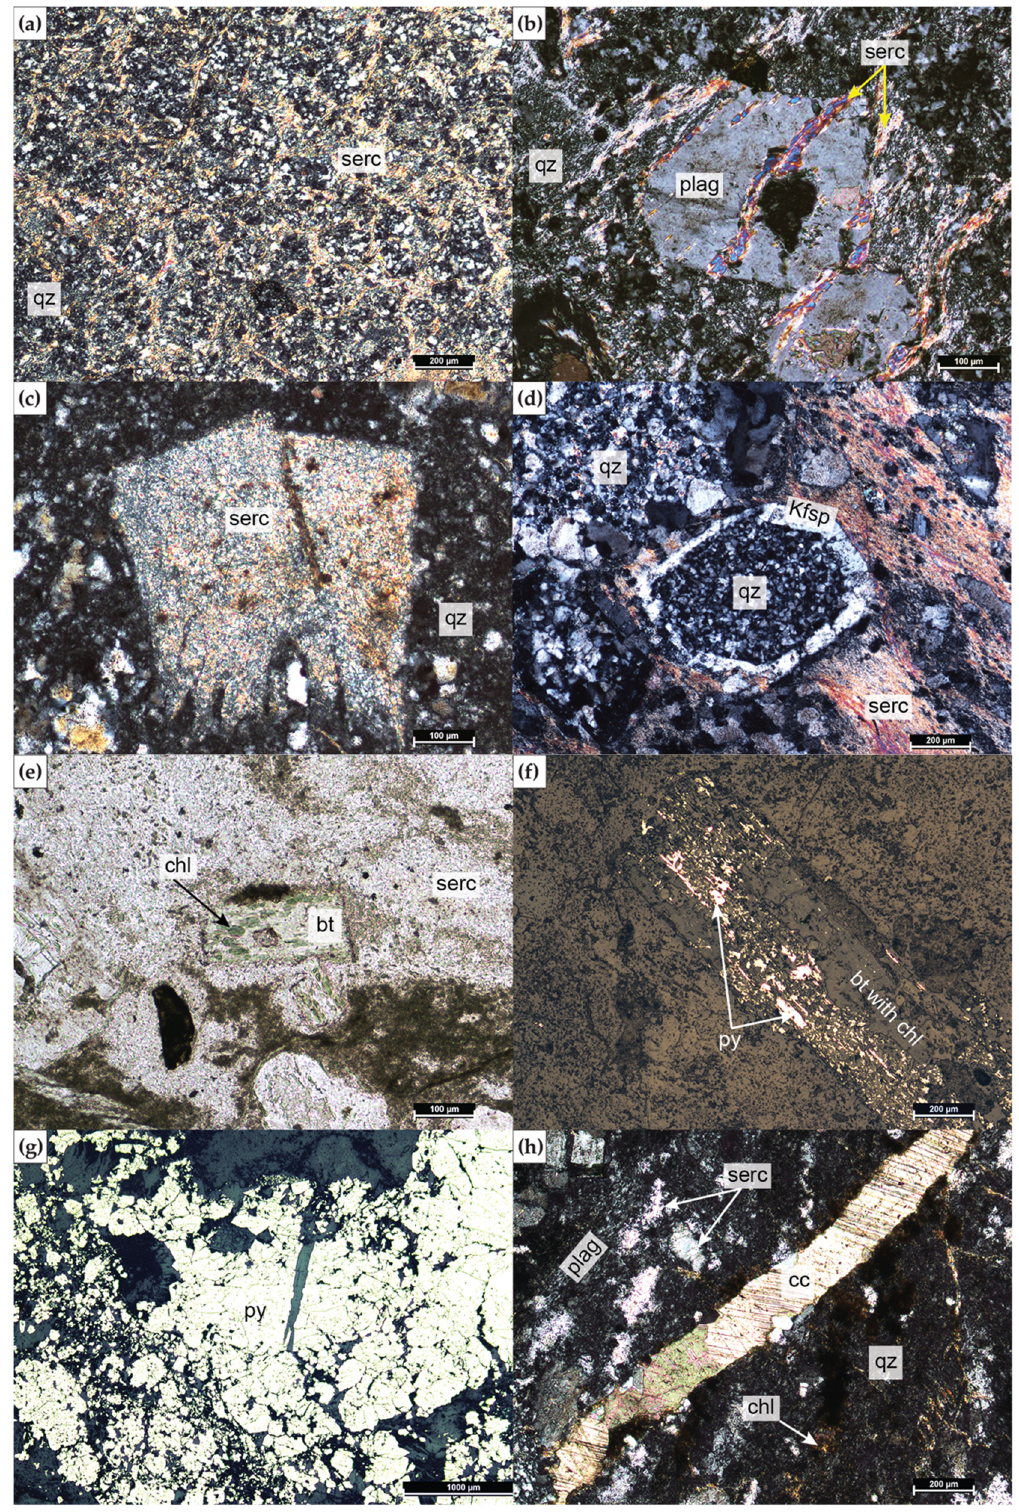
Figure 13. Alteration assemblage and texture in altered felsic units, ( a ) pervasive sericite and quartz alteration, ( b ) plagioclase phenocrysts in quartz-sericite altered matrix and partly altered to sericite, ( c ) completely sericitized feldspar phenocryst in quartz-sericite matrix, ( d ) plagioclase pseudomorph with quartz core and rim of secondary K-feldspar in sericite-quartz matrix, ( e ) biotite partly altered to chlorite, ( f ) pyrite in partly chloritized biotite, ( g ) anhedral pyrite aggregate, ( h ) calcite veinlet cross-cutting sericitized plagioclase in quartz-sericite-chlorite matrix. Abbreviations: bt—biotite, chl—chlorite, cc—calcite, K-fsp—K-feldspar, plag—plagioclase, py—pyrite, qz—quartz, serc—sericite.